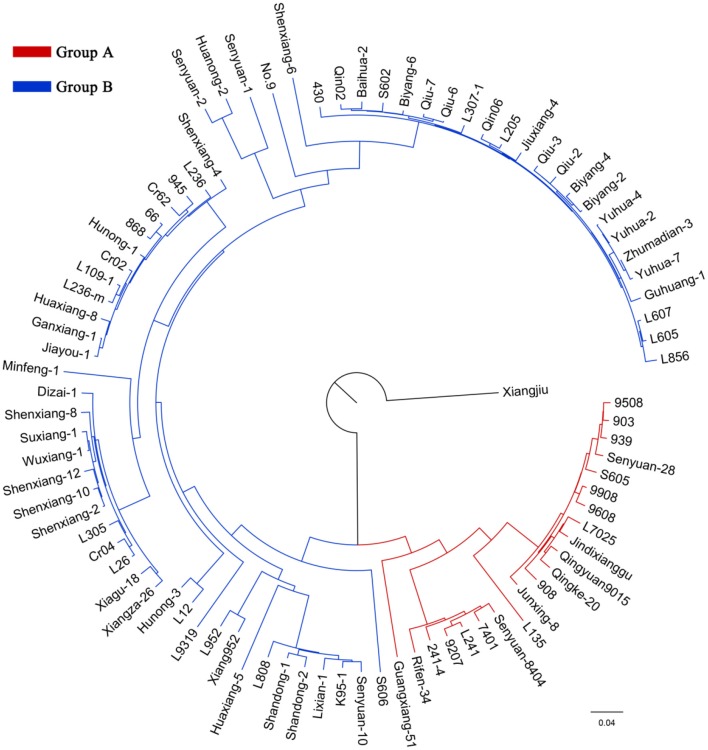
A neighbor-joining tree of 89 Lentinula edodes cultivars. The ancestors of the strains in the inferred groups are represented by different colors.